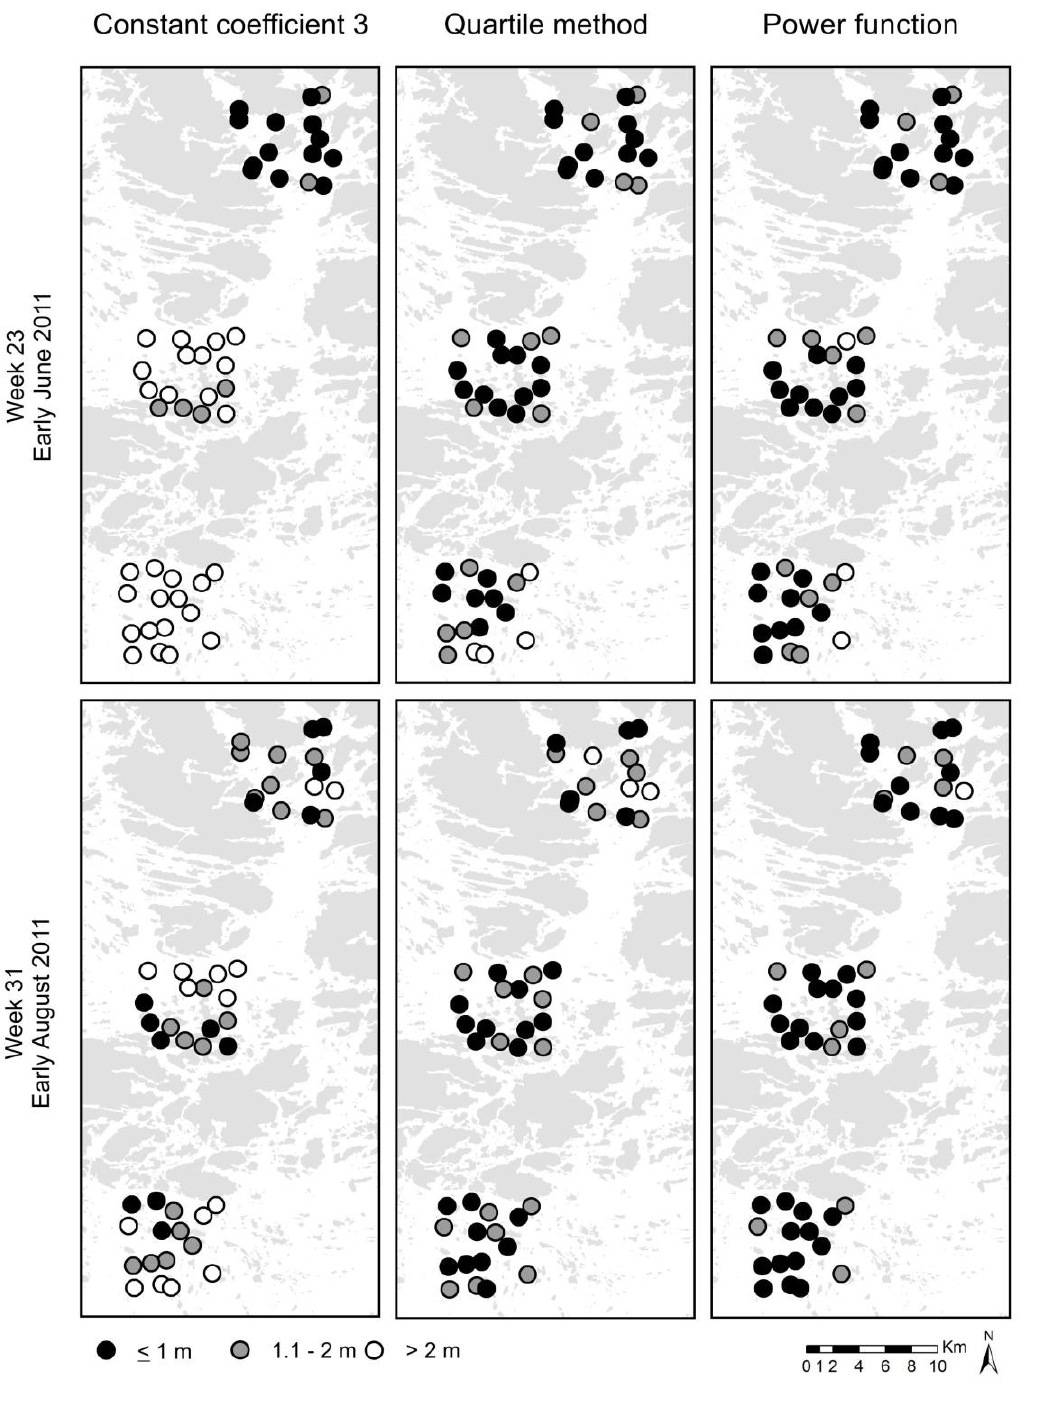
Figure 4. The applicability of two conversion methods locally calibrated in this study were tested with independent data, and the performance was compared with that of a common fixed coefficient 3. The differences between the modeled and observed Z plotted on maps. The figure illustrates spatio-temporal variability in the conversion accuracy among three test areas located in different parts of the optically varying coastal archipelago area, and between two timings representing different phases of the seasonal variations in the optical